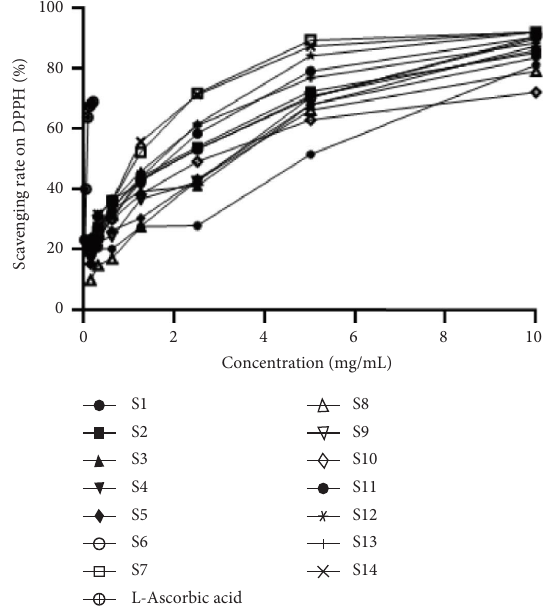
Figure 5: DPPH free radical-scavenger activity of fourteen batches of CRC leaves